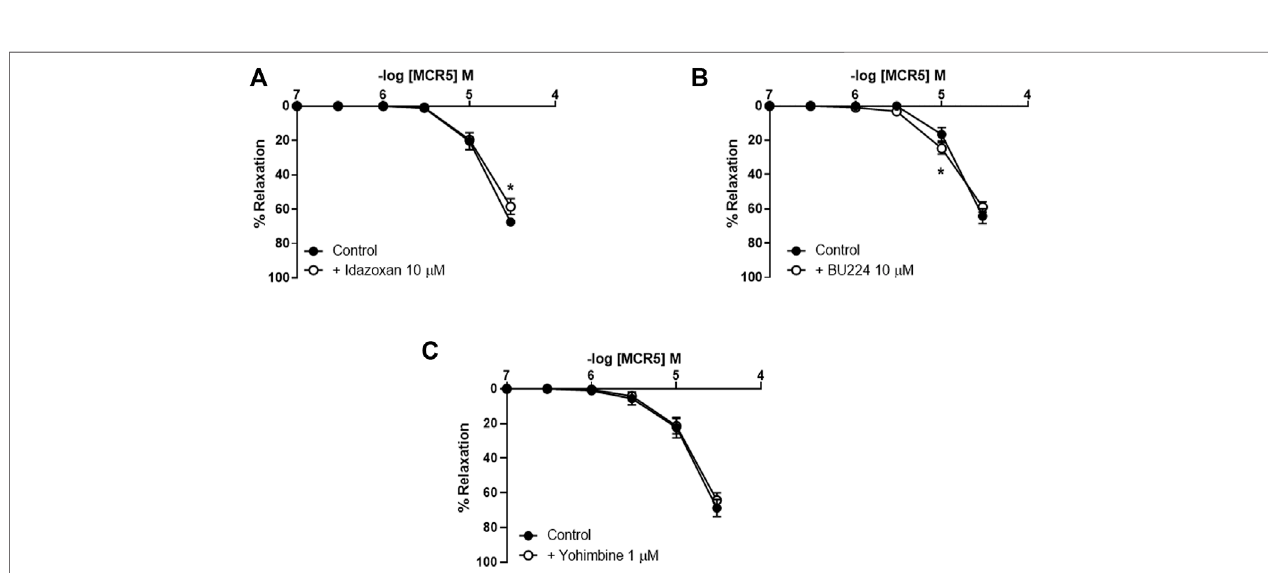
FIGURE 2 | Effects of I 2 R modulators and antagonism of α 2 -adrenoceptors on MCR5 relaxations. Concentration-response curves to MCR5 in U46619-pre- contractedaorticrings from youngOF1mice inthe absence(control)orpresence ofthe I 1 R and I 2 R ligandidazoxan (10 µM) (A) theI 2 RligandBU224 (10 µM) (B) ,or the α 2 -adrenoceptor antagonist yohimbine (1 µM) (C) . Results are mean ± SEM from n = 7 (A) , 8 (B) , and 6 (C) . Bonferroni ’ s post hoc